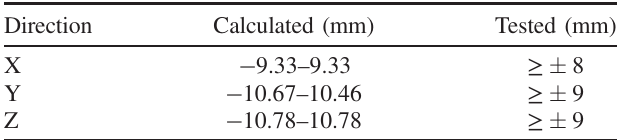
TABLE VI. The adjusting ranges of the girder prototype.